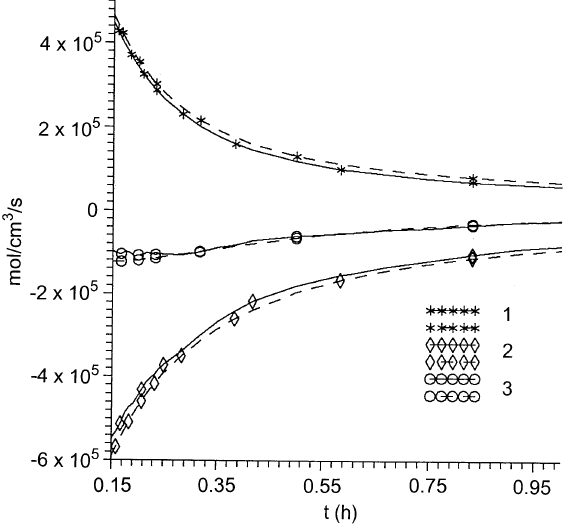
Fig. 5. Same as in Fig. 4 but for OH evolution